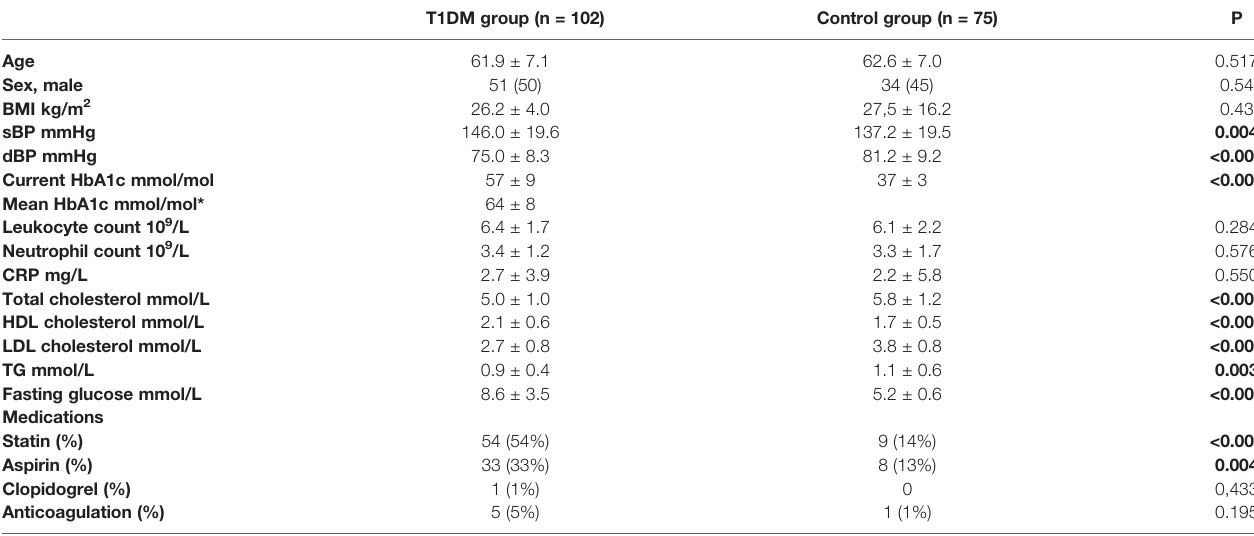
TABLE 1 | Clinical and demographic characteristics of the study population.